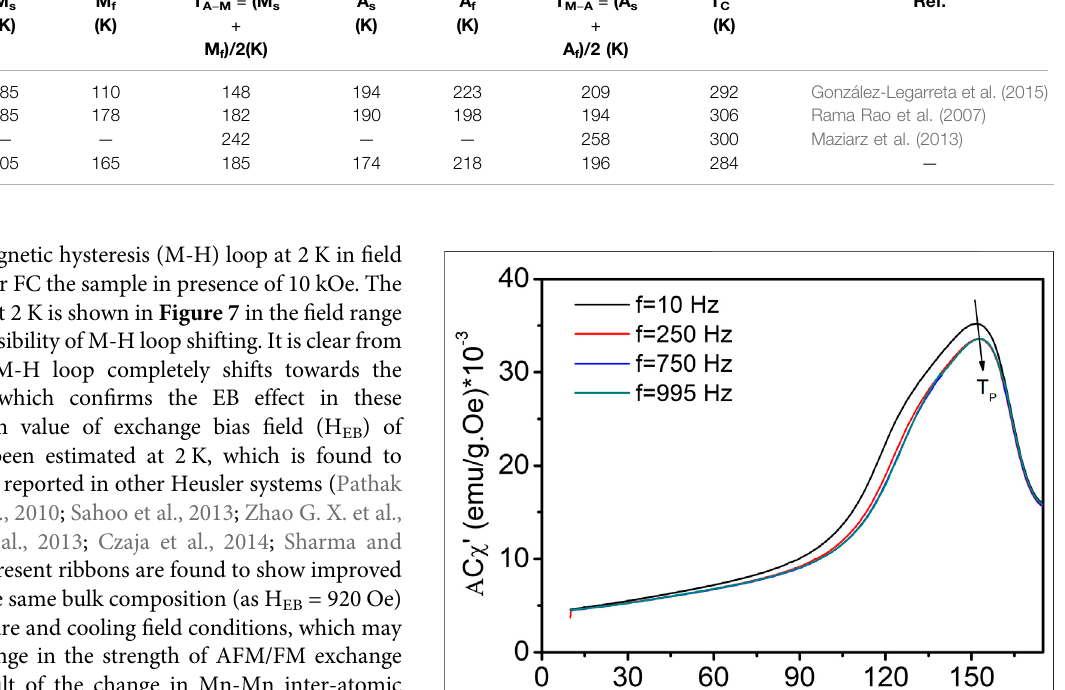
TABLE 1 | Comparison of various martensitic transition temperatures obtained for other Heusler alloys ribbons reported in literature with the present ribbons. Alloy (composition)